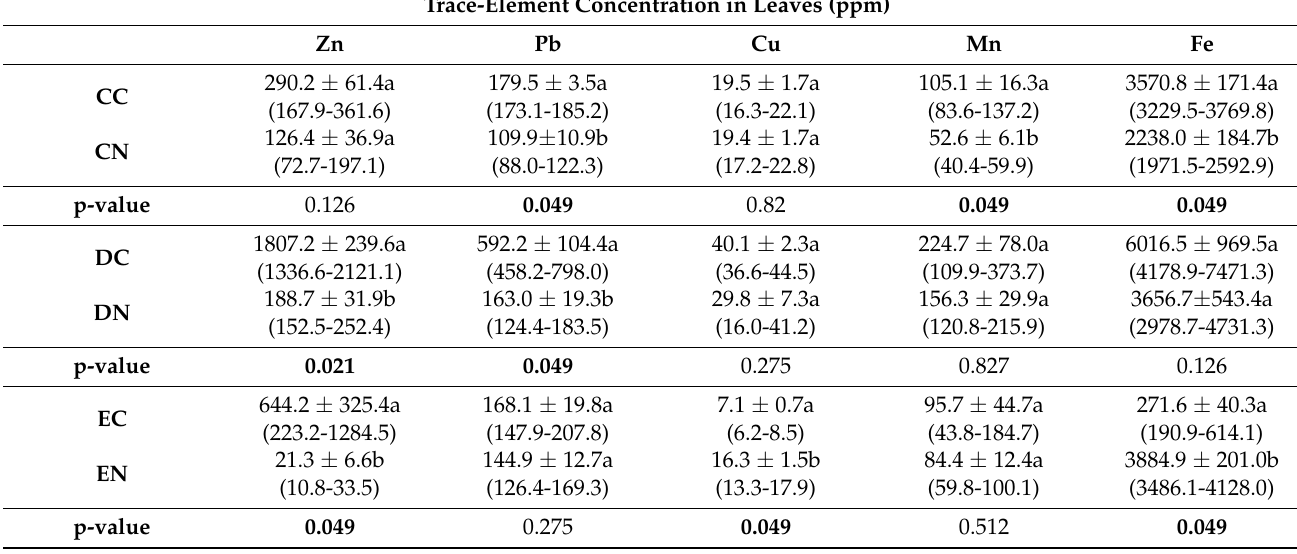
Table 2. Trace-element concentration in leaves. Mean ± SE value is indicated, and minimum and maximum values are shown in brackets. The non-parametric Kruskal–Wallis test was applied. Different letters indicate significant differences at a significance level < 0.05 within the same element and plant species. CC = contaminated soil under C. salviifolius , CN = uncontaminated soil under C. salviifolius , DC = contaminated soil under D. viscosa , DN= uncontaminated soil under D. viscosa , EC = contaminated soil under E. pithyusa , EN = uncontaminated soil under E. pithyusa .